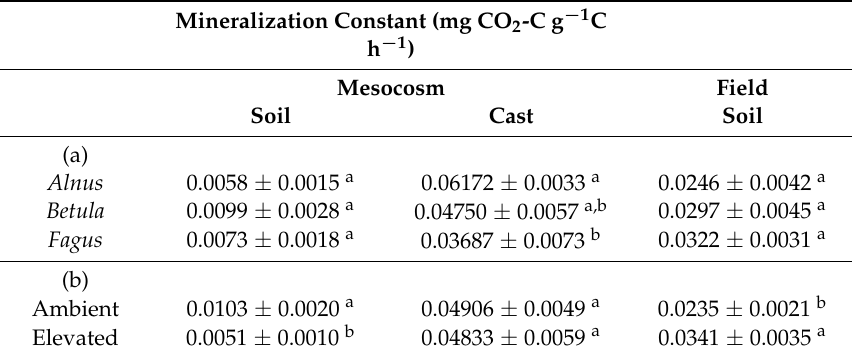
Table 5. Effect of ( a ) litter species and ( b ) CO 2 regime on mineralization constant in aggregates from the mesocosm and field